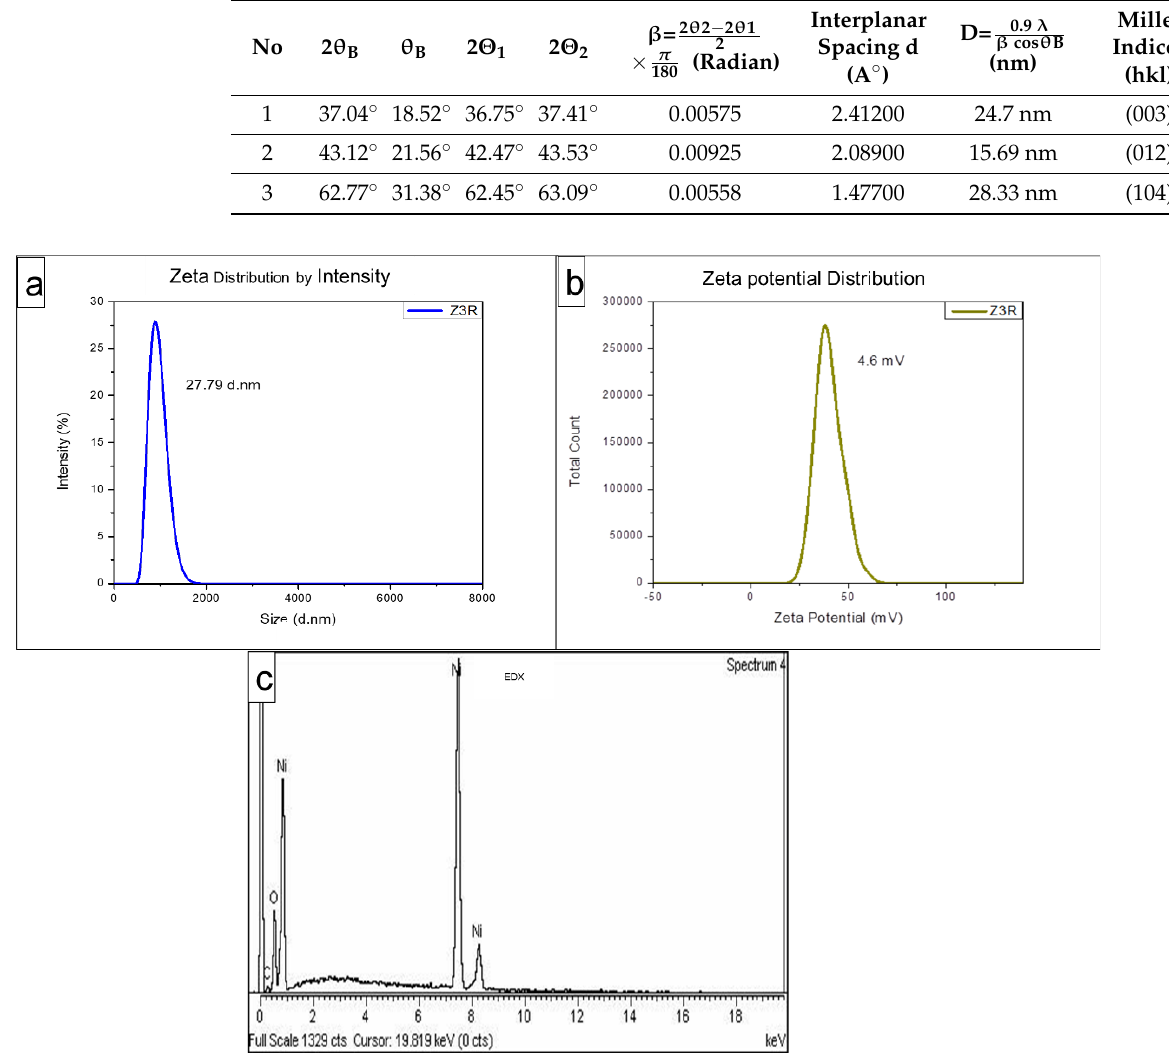
Table 2. XRD analysis of BPL based NiONPs.